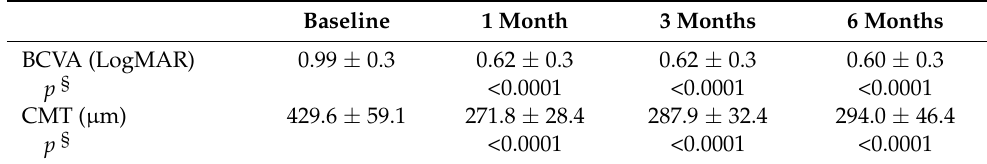
Table 2. Changes of outcomes over